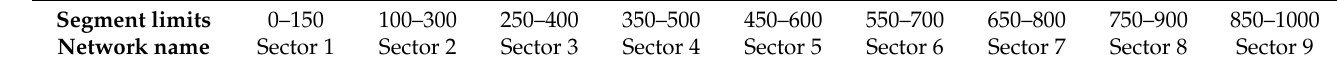
Table 1. Segments used to train the machine learning models for enhanced damage